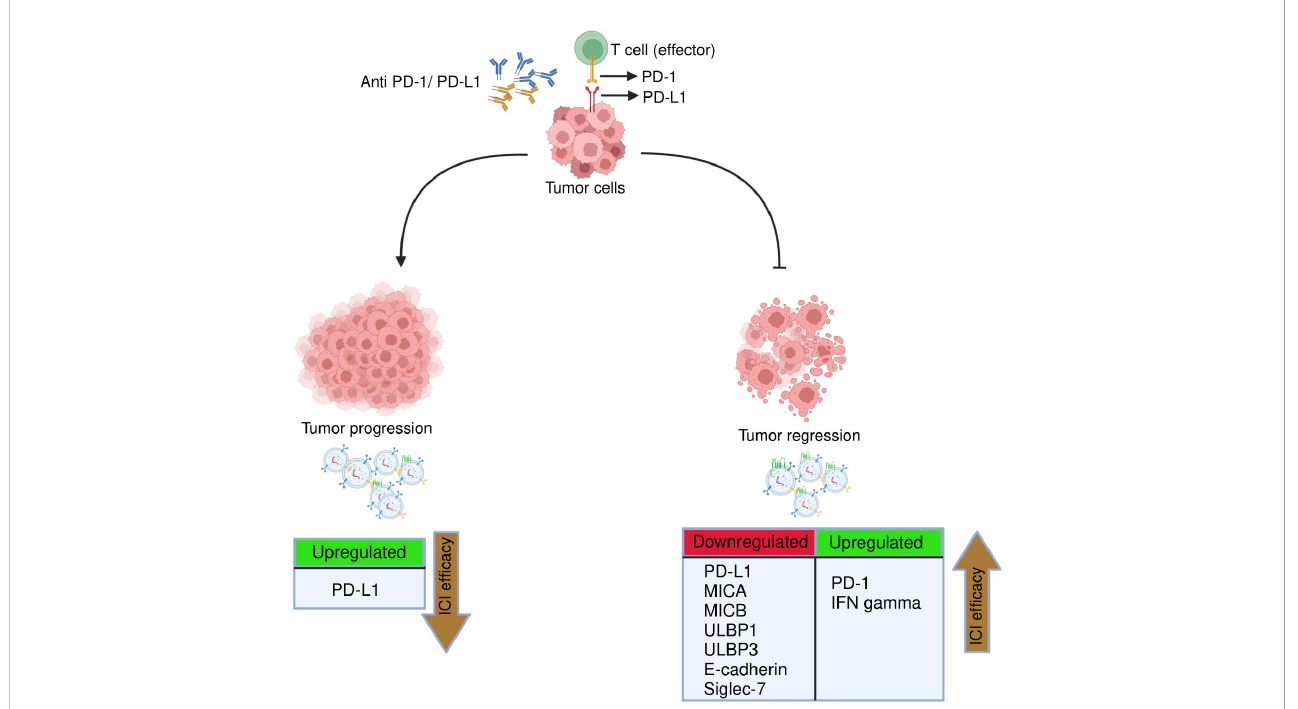
FIGURE 10 Representation of key immuno-oncological markers and cytokines derived from exosomes associated with clinical response to anti-PD-1/PD-L1 therapy. The ef fi cacy of anti-PD-1/PD-L1 therapy in NSCLC treatment can be monitored/predicted by the presence of following exosomal immune checkpoints, NK markers and cytokines. Tumor regression: Downregulation of exosomal PD-L1, MICA, MICB, ULBP1, ULBP3, E-cadherin, siglec-7 and upregulation of exoPD-1 and exoIFN- g linked to better ICIs ef fi cacy. Tumor progression: upregulation of exoPD-L1 associated with poor ICIs ef fi